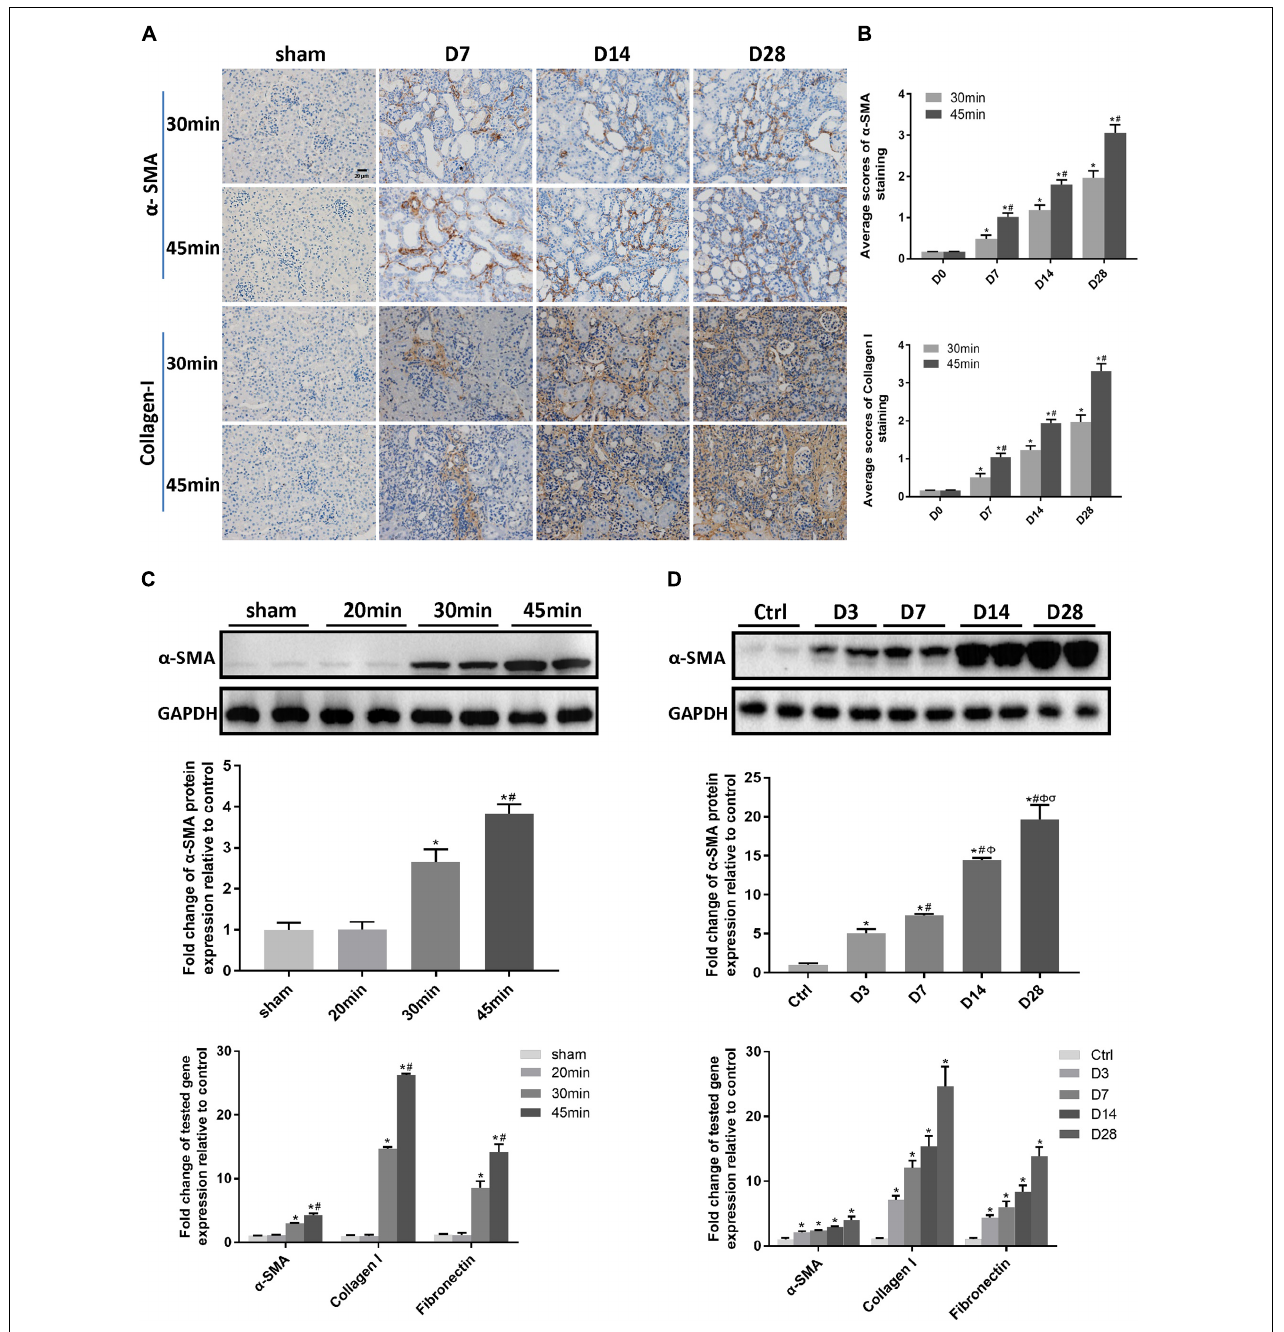
FIGURE 3 | A long ischemia duration induced kidney fibrosis in IRI mice. (A) Immunohistochemical staining of α -SMA and collagen I in kidneys, with representative pictures shown (original magnification × 400; Scale bar, 20 µ m). (B) Semiquantitative data of α -SMA and collagen I staining in different groups of mice. ∗ P < 0.05 vs. the control group. # P < 0.05 vs. the 30-min ischemia group. (C) Protein and mRNA expression of fibrosis markers in the kidney tissue lysates of mice subjected to different durations of ischemia at day 28 post-operation. ∗ P < 0.05 vs. the sham control group. # P < 0.05 vs. the 30-min ischemia group. (D) Protein and mRNA expression of fibrosis markers in the kidney tissue lysates of mice subjected to 45 min-IRI at different time points post ischemia. ∗ P < 0.05 vs. the baseline control group. # P < 0.05 vs. Day 3. (cid:56) P < 0.05 vs. Day 7. σ P < 0.05 vs. Day 14. All data above are presented as the means ± SEM of four experiments. n = 6.